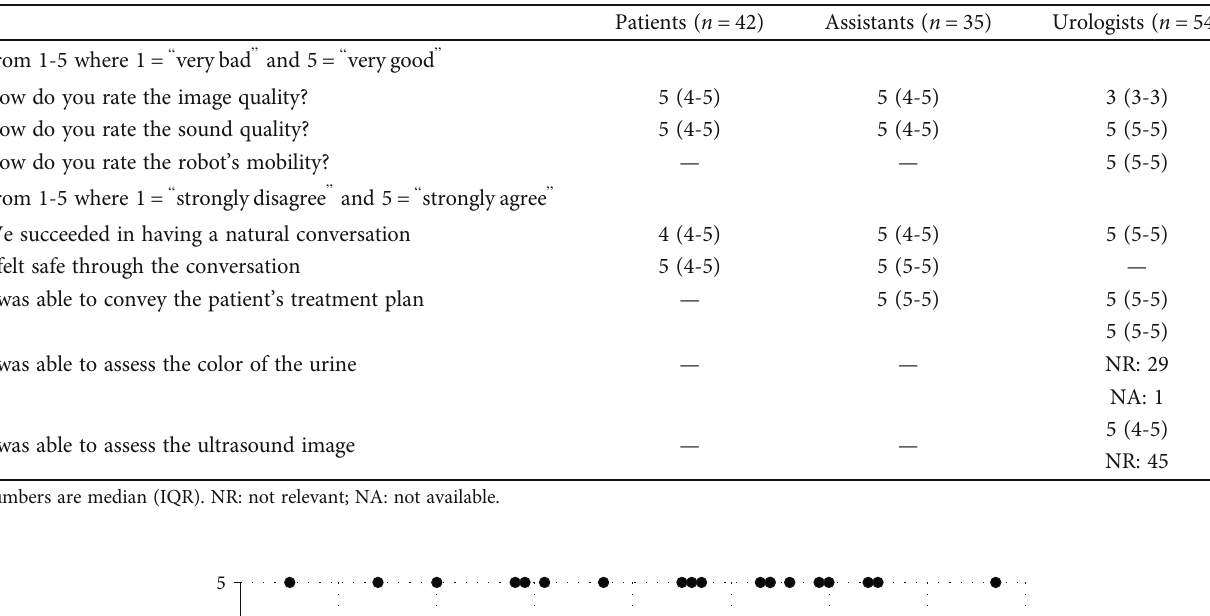
Table 2: Questionnaire responses.